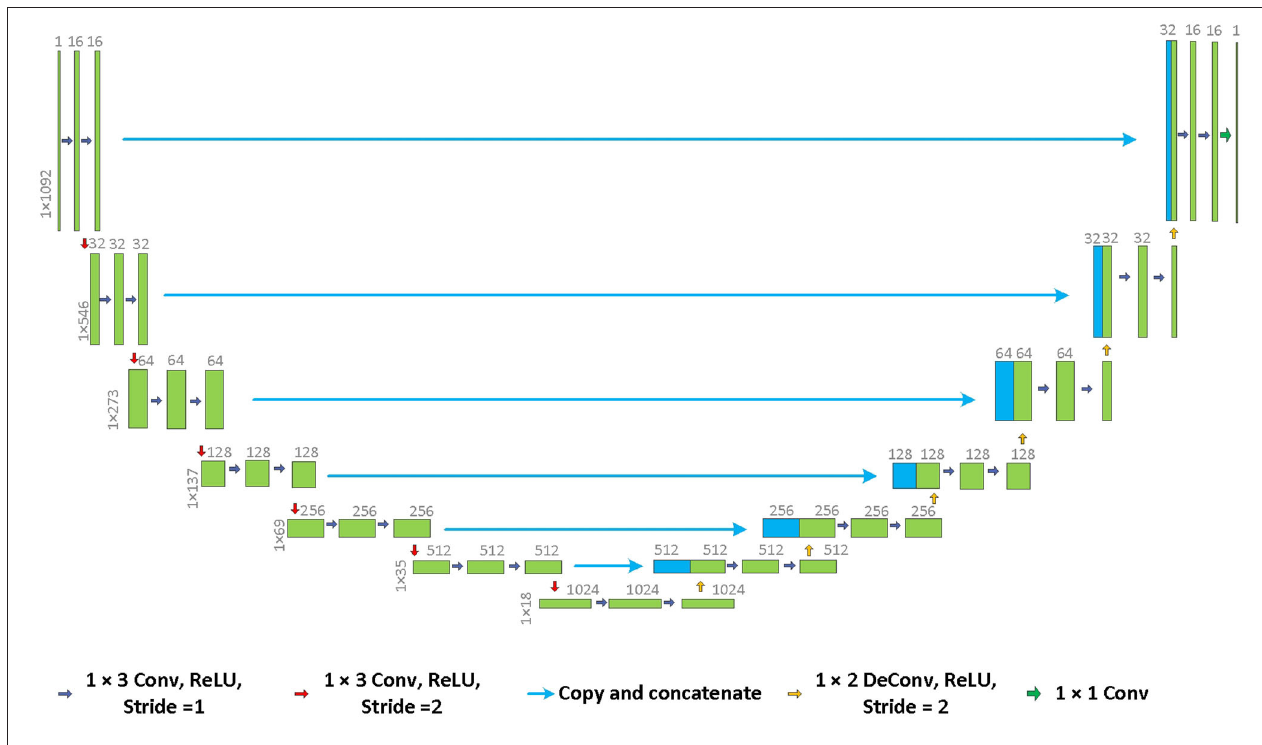
FIGURE 2 | The architecture of 1D